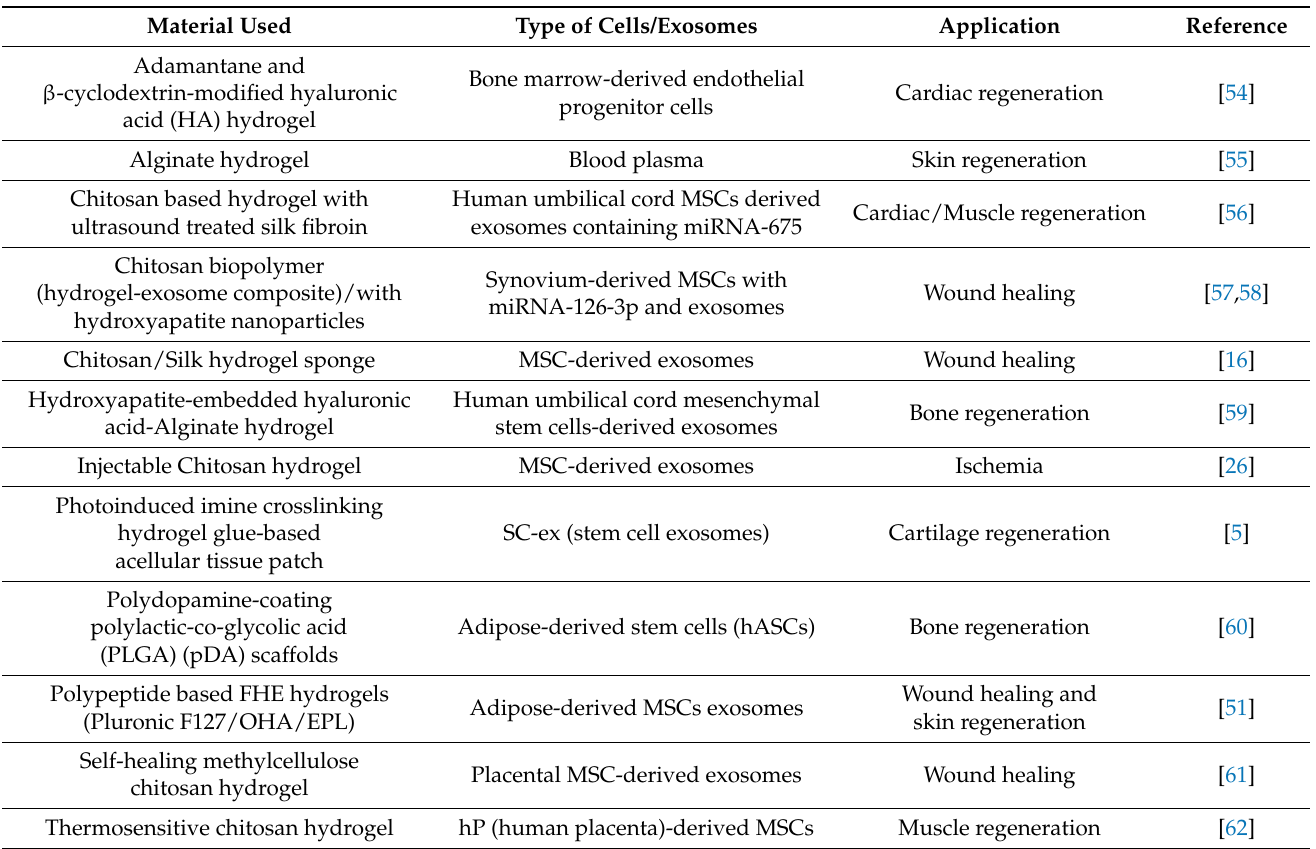
Table 1. Summary of the most commonly used hydrogel-based systems incorporating exosomes/stem cells, with their corresponding applications. Material